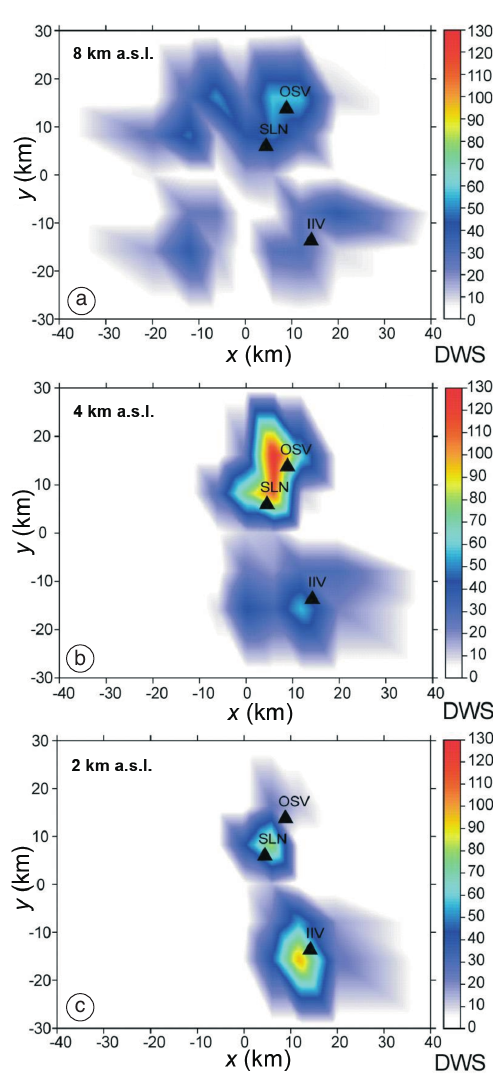
Fig. 8a-c. Derivative Weight Sum (DWS) at hori- zontal planes placed respectively at the height of 8, 4 and 2 km